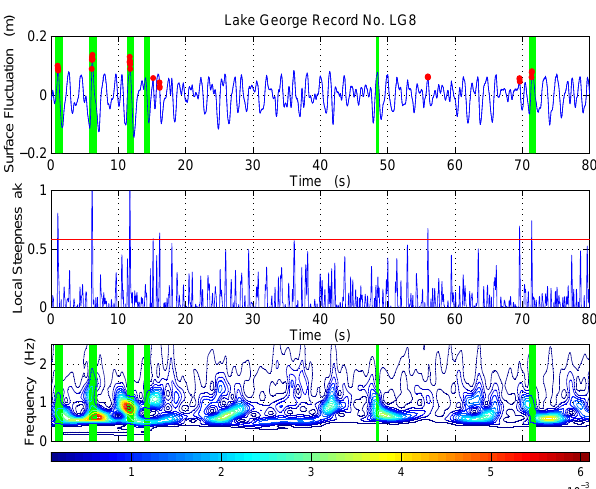
Fig. 5. ( a ) Comparing breaking events detected from wavelet ap- proach in red dots with Lake George measurement in green vertical bars. ( b ) Local steepness ak . The straight line shows γ = 0 . 6, which is the chosen threshold value. ( c ) Instantaneous wave spectra in rel- ative units (colour scale below). The horizontal axis is the time axis, same as in the top two